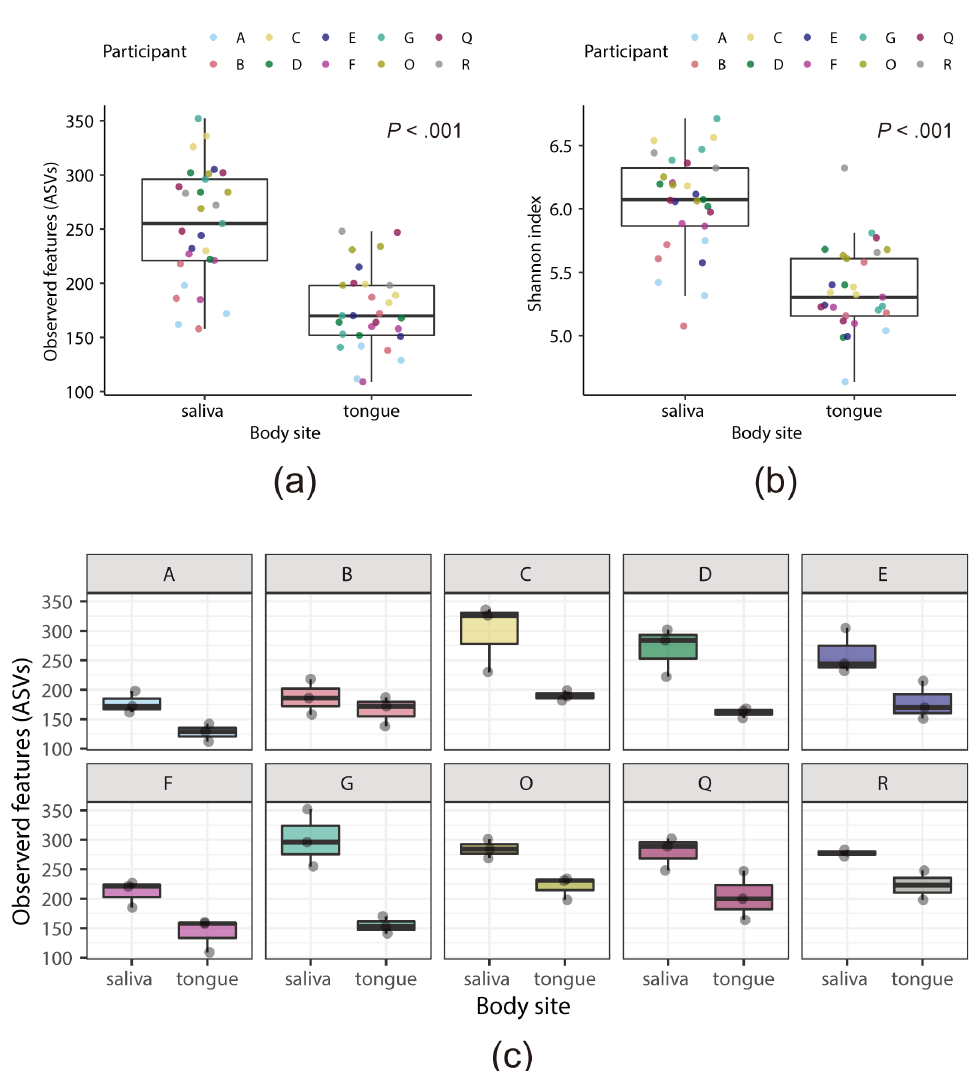
Figure 2. Alpha diversity of the salivary and tongue microbiomes. Data from the full amplicon sequence variants (ASV) table were used to calculate the alpha-diversity indexes. ( a , b ) Thirty samples each from the salivary or tongue microbiome were compared (three D1 samples for each of 10 participants). The number of observed ASVs ( a ) or Shannon index ( b ) was used as the alpha-diversity measure. Each point indicates a sample. Colors of the points indicate different participants. ( c ) Box plots of the number of observed ASVs in the salivary and tongue microbiomes (n = 3 each) for each